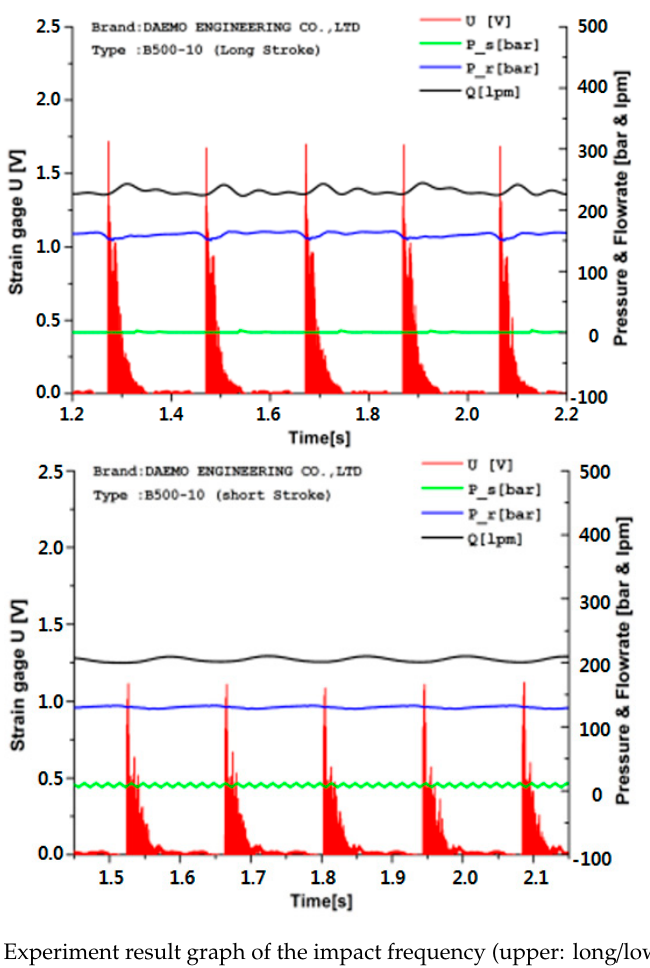
Figure 10. Experiment result graph of the impact frequency (upper: long/lower: short).